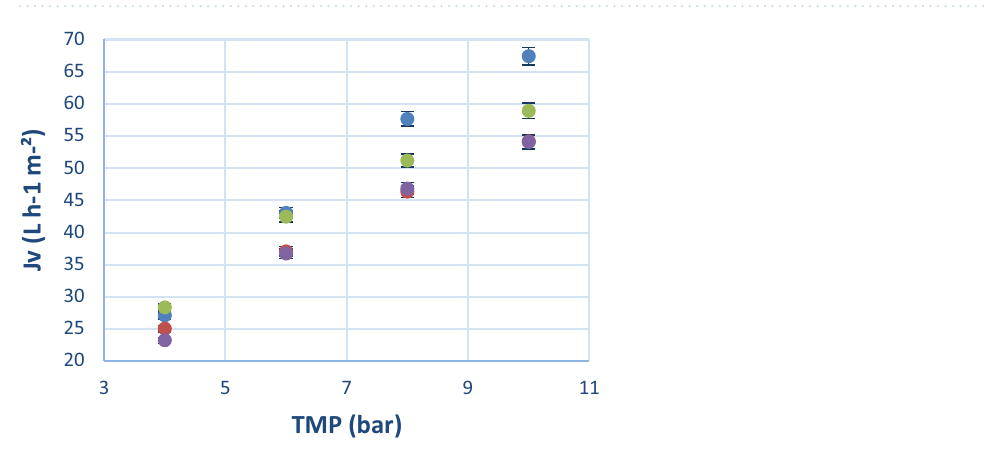
Figure 3. Effect of pressure (TMP) on the compounds’ retention for ( A ) NP010 and ( B ) GK membranes with model solution. ( ) (CoAS) 2 , ( ) ATP, ( ) ADP, ( ) AMP.